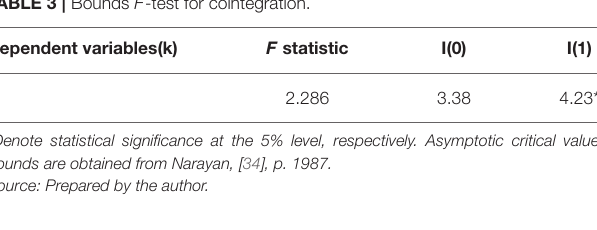
TABLE 4 | Results of Hatemi-J asymmetric causality test.